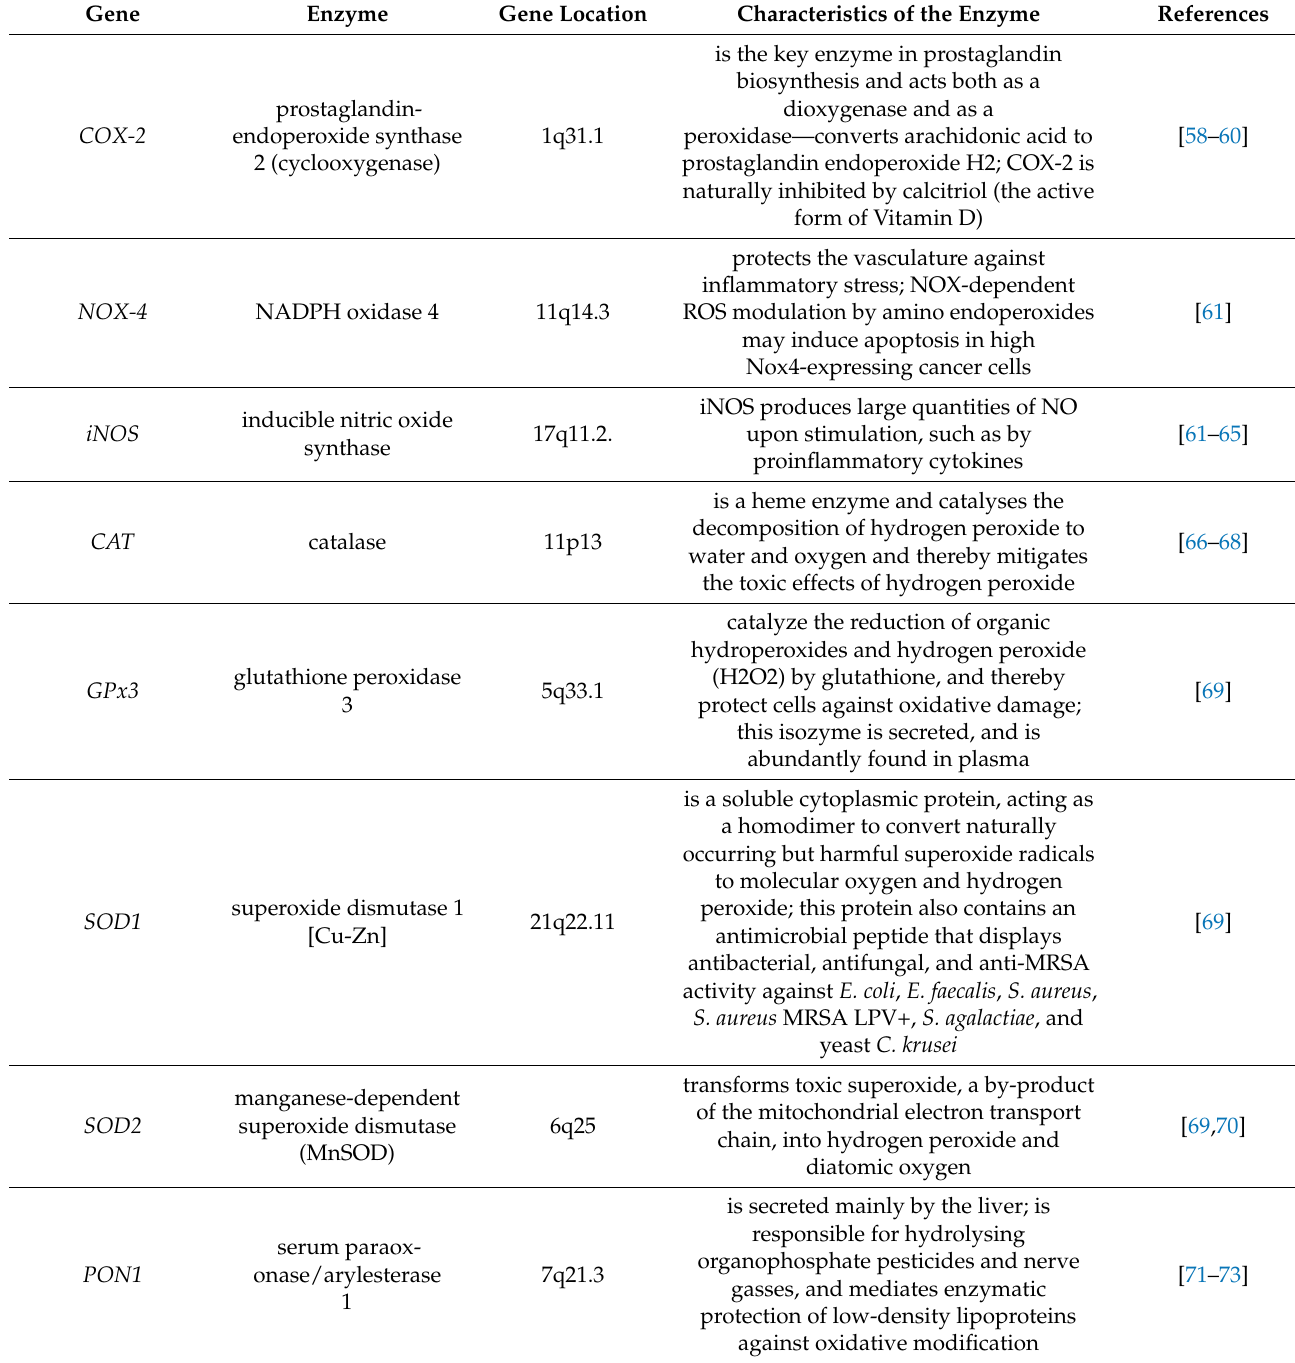
Table 2. The compounds associated with oxidative